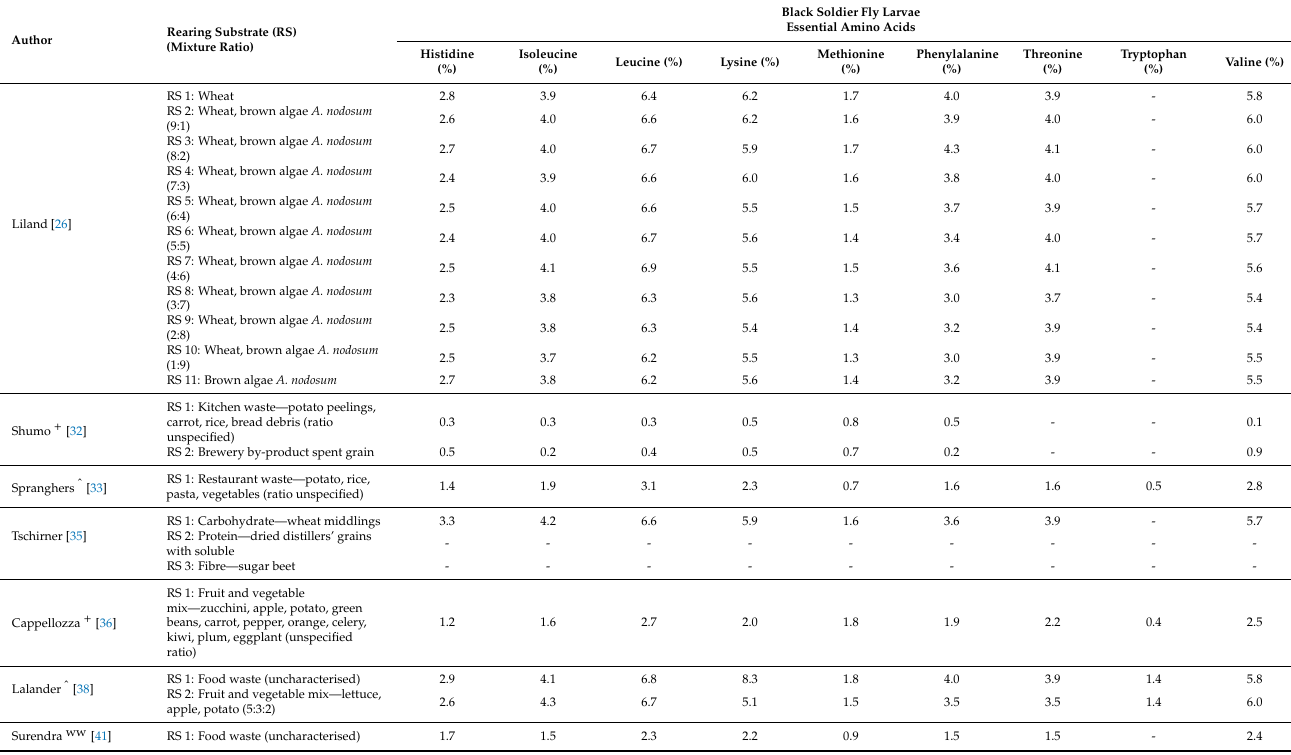
Table 4. Essential Amino Acid Profile of Black Soldier Fly Larvae Reared on Food